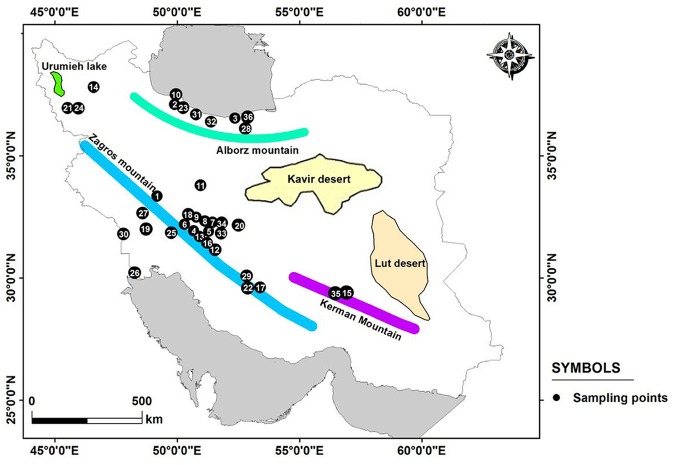
Study area indicating 36 sites of Potamogeton pectinatus in Iran.Numbering as in
Table 1. 1: Aligoodarz; 2: Amirkelaieh; 3: Azbaran; 4: Barm; 5: Borujen; 6: Chaghakhor; 7: Chamaseman, 8: Chamgordan; 9: Chamtagh; 10: Dahaneh sefidrood; 11: Delijan; 12: Dizicheh; 13: Gandoman; 14: Ghoorigol; 15:Googhar; 16: Hamzeali; 17: Hasanabad; 18: Hojatabad; 19: Izeh; 20: Jarghoieh; 21: Kaniborazan; 22: Komjan; 23: Langrood; 24: Miandoab; 25: Miangaran; 26: Shadegan; 27: Shushtar; 28:Siahrood; 29: Sivand; 30: Soosangerd; 31: Tonekabon; 32: Valasht; 33: Varnamkhast; 34: Vimcheh; 35: Yaschaman; 36: Zaghmarz.